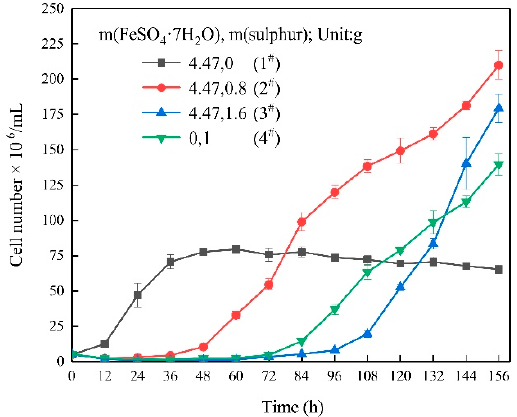
Figure 1. The graph of cell density over time from experimental systems.